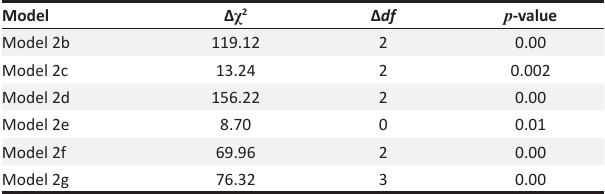
TABLE 4: Difference testing for competing structural models. Model